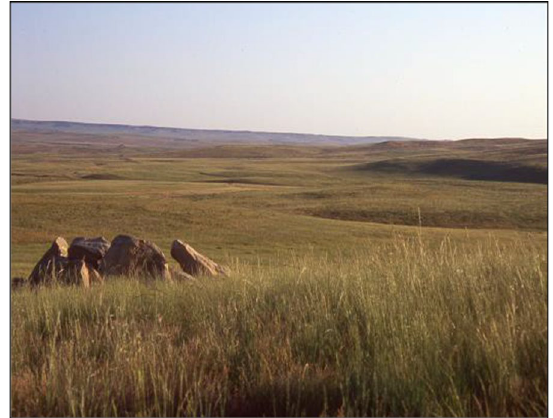
Fig. 6 Pre-SMCRA reclaimed land